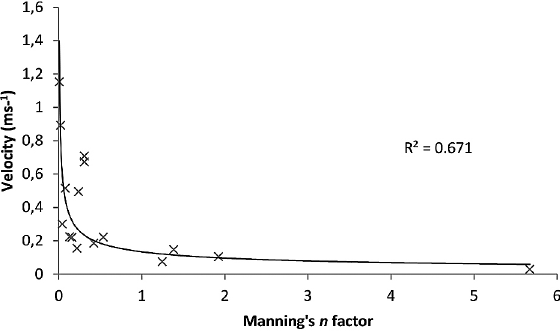
Fig. 6. Velocity decreases with increasing Manning’s n